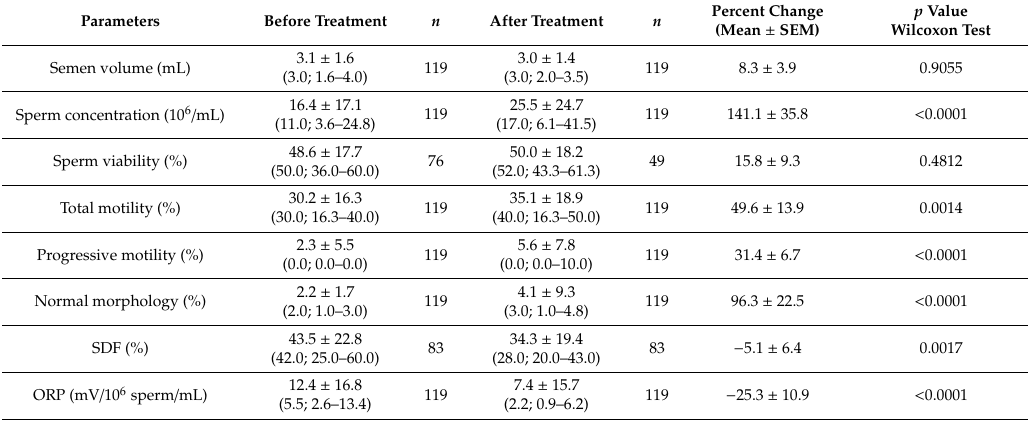
Table 2. Summary statistics of semen parameters, SDF, and ORP before and after the treatment of idiopathic infertile patients with FH PRO for Men.